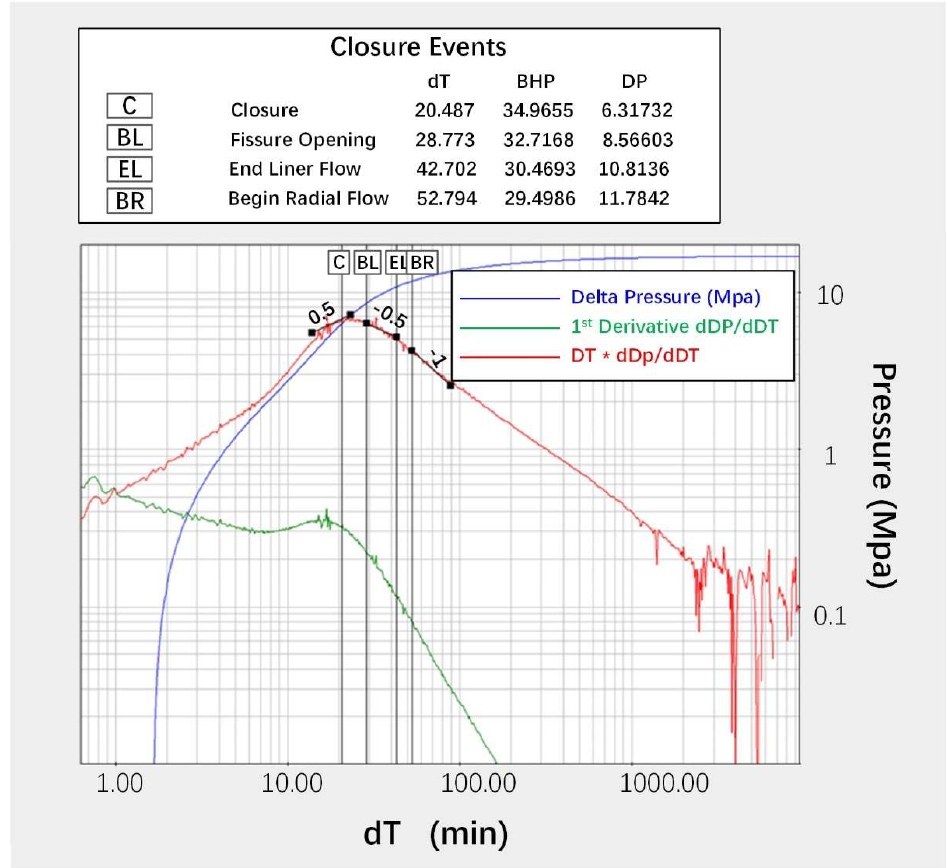
Figure 12. Pore pressure is estimated by pressure transient analysis. The main image shows pore pressure determination by linear flow regime, and the inserted image shows pore pressure determination by radial flow regime.